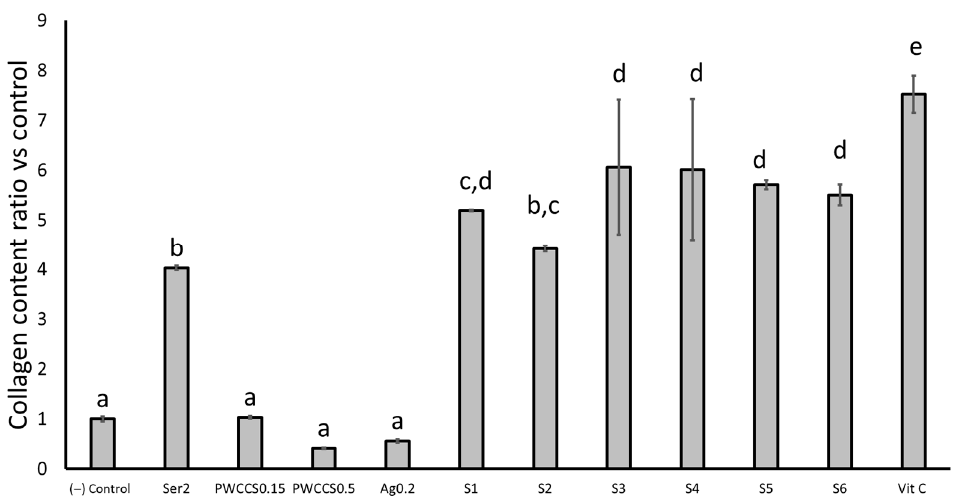
Figure 10. Collagen content ratio vs. the control of the NHDF cells after 24 h treatment with 2% sericin (Ser2), 0.15% PWCCS (PWCCS0.15), 0.5% PWCCS (PWCCS0.5), 0.2% alginate (Ag0.2), 25 µ g/mL ascorbic acid (Vit C), and the formulations S1–S6. Data represent the mean ± SEM of the three replicates. Statistical significance was evaluated by Duncan’s post-hoc test; a–e letters indicate significant differences between the group at p < 0.05.